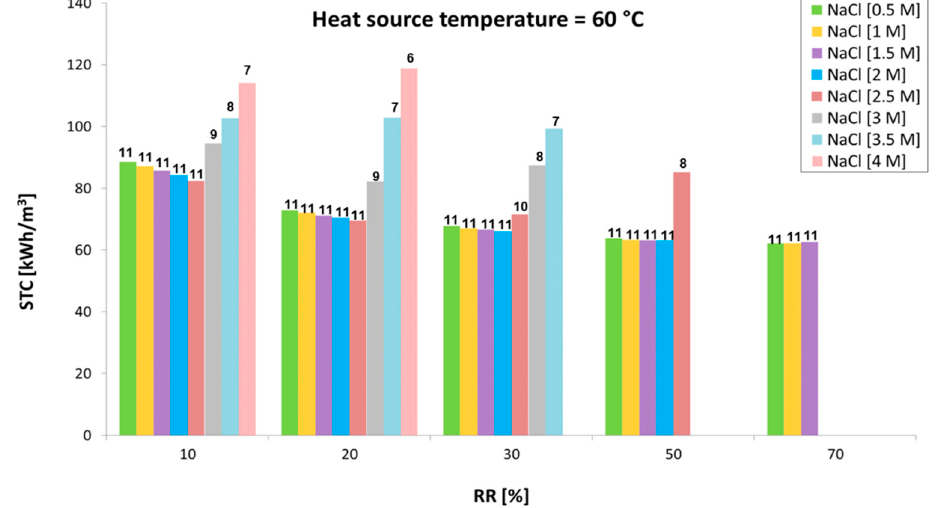
Figure 10 . Variation of the specific thermal consumption with the recovery ratio at different inlet concentrations with a heat source at 60 °C.